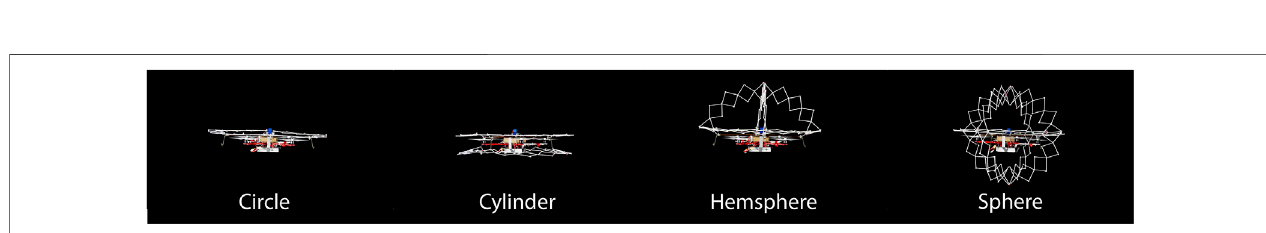
FIGURE 10 | PufferBot can exhibit various communicative behaviors when humans approach the robot. Above, PufferBot expands as a user approaches to warn the human to stay away from the robot.